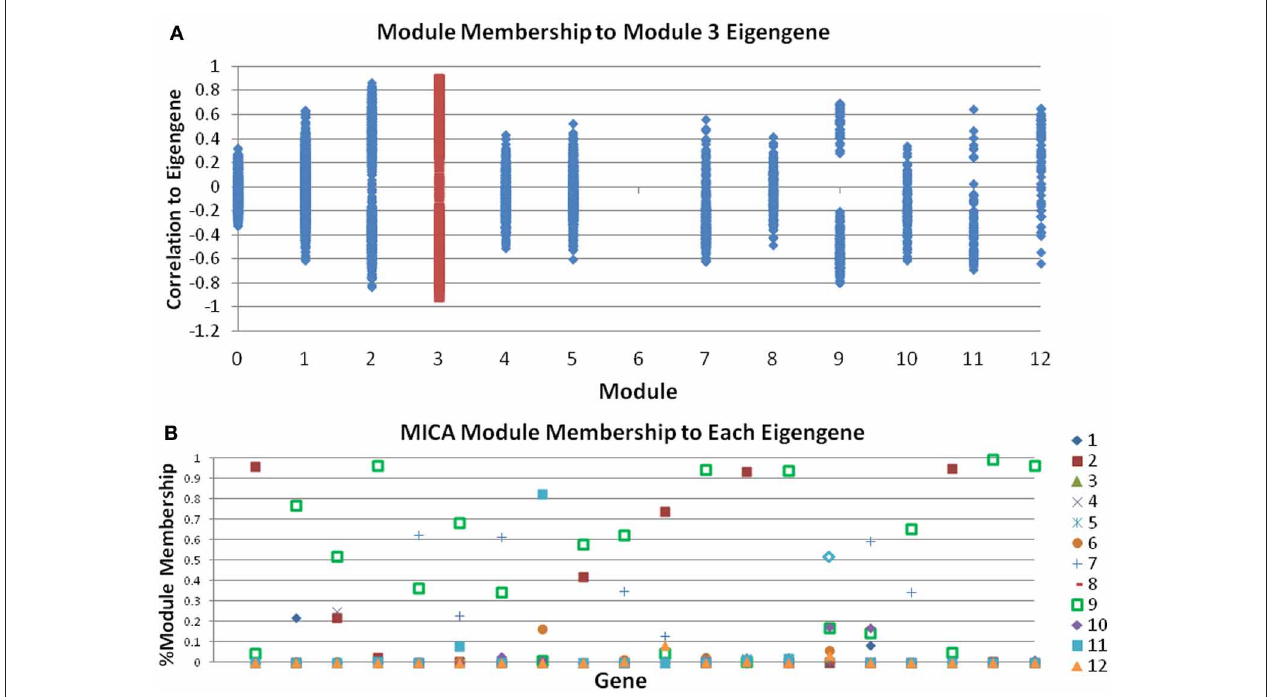
FIGURE 2 | Module Memberships are more meaningful in MICA. (A) Module membership comparisons between all modules and the eigengene of module 3 for the macrophage dataset as calculated by WGCNA. Many genes in other modules, notably modules 2 and 9, have stronger correlations